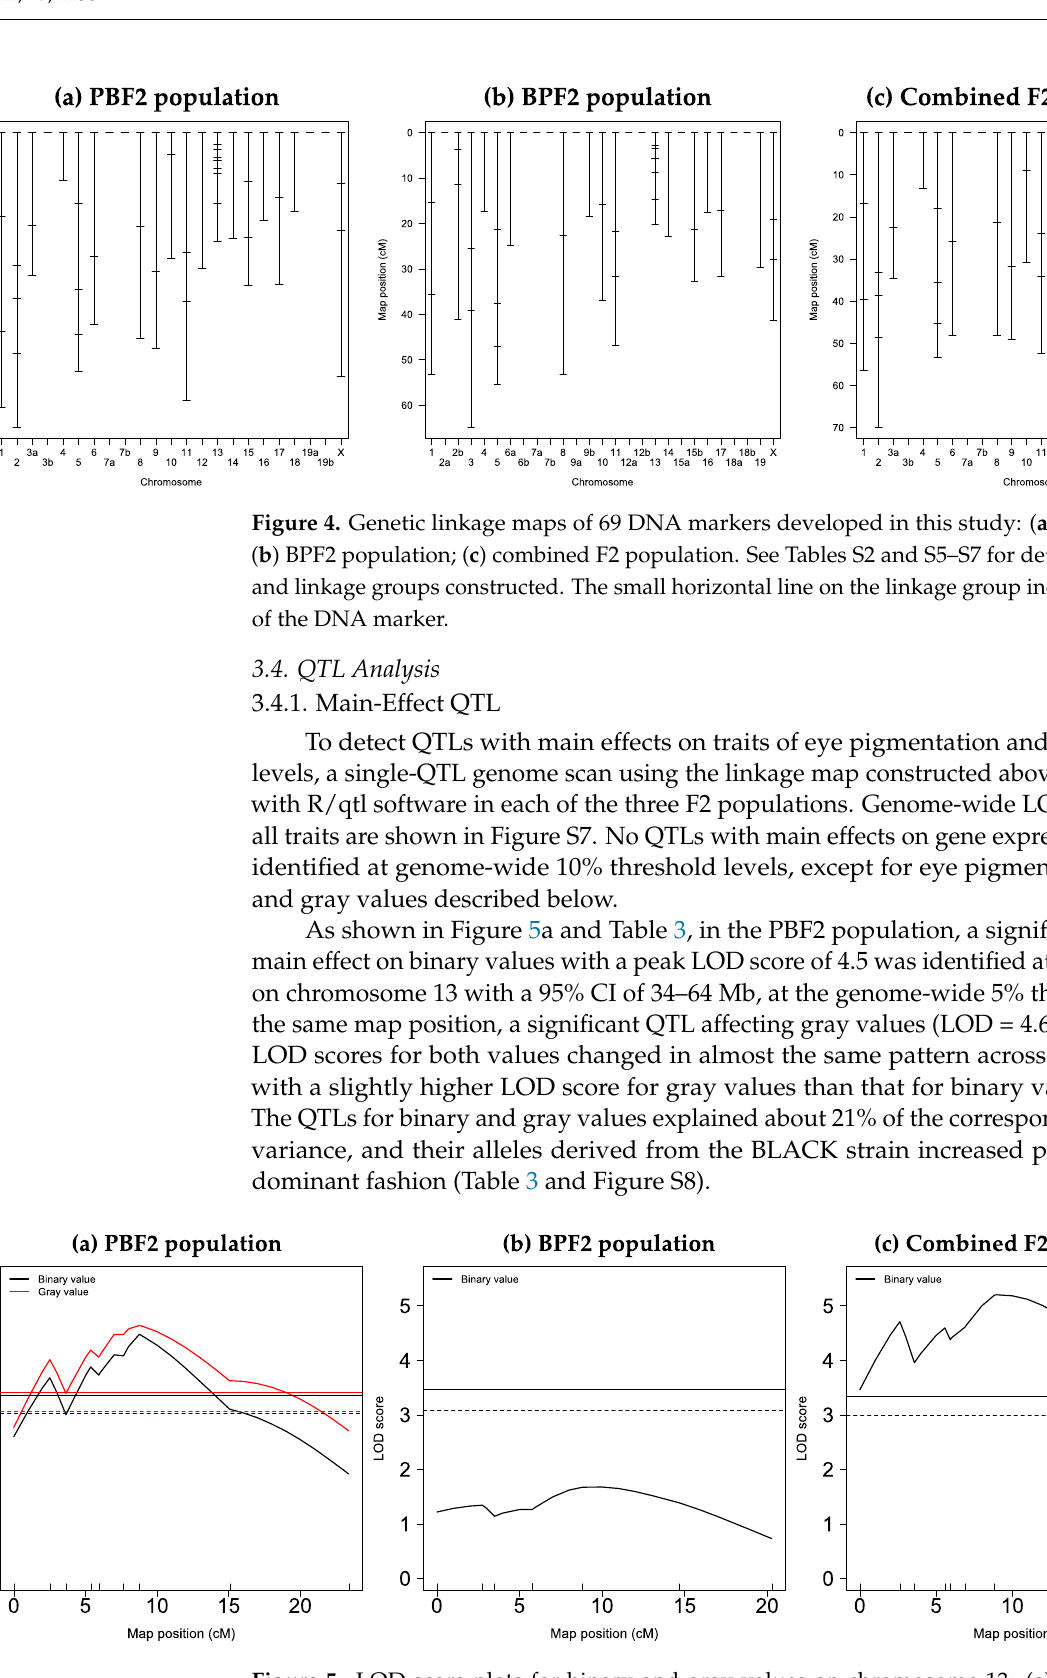
Figure 5. LOD score plots for binary and gray values on chromosome 13: ( a ) PBF2 population; ( b ) BPF2 population; ( c ) combined F2 population. The solid and dashed horizontal lines show genome-wide 5% and 10% significant threshold levels obtained by 10,000 permutations for each trait (see Table S8). The small vertical line on the x -axis indicates the position of each DNA marker. Table 3. Summary of QTLs for eye pigmentation on chromosome 13 identified in this study.